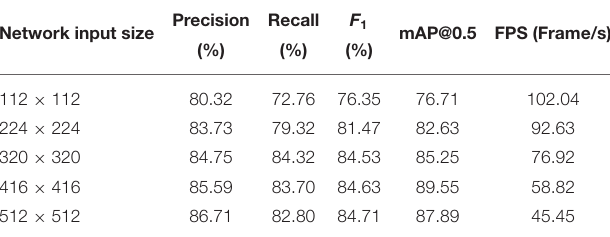
TABLE 2 | Grape downy mildew Detection performance with different network input